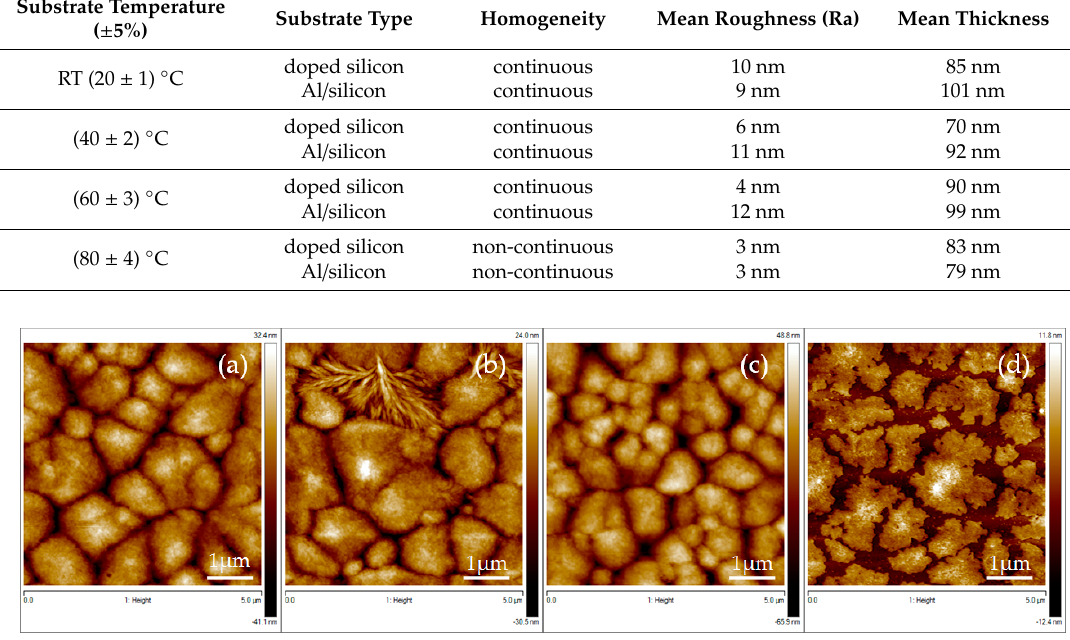
Figure 4. 5 × 5 µm AFM micrographs showing the morphology of PVDF thin films spin-coated on Figure 4. 5 × 5 µ m AFM micrographs showing the morphology of PVDF thin films spin-coated on silicon at di ff erent temperature: PVDF films obtained at ( a ) 20 ◦ C; ( b ) 40 ◦ C; ( c ) 60 ◦ C and ( d ) 80 ◦ Table 2. Morphology characteristics of the PVDF thin films as function of the substrate temperature and the substrate type